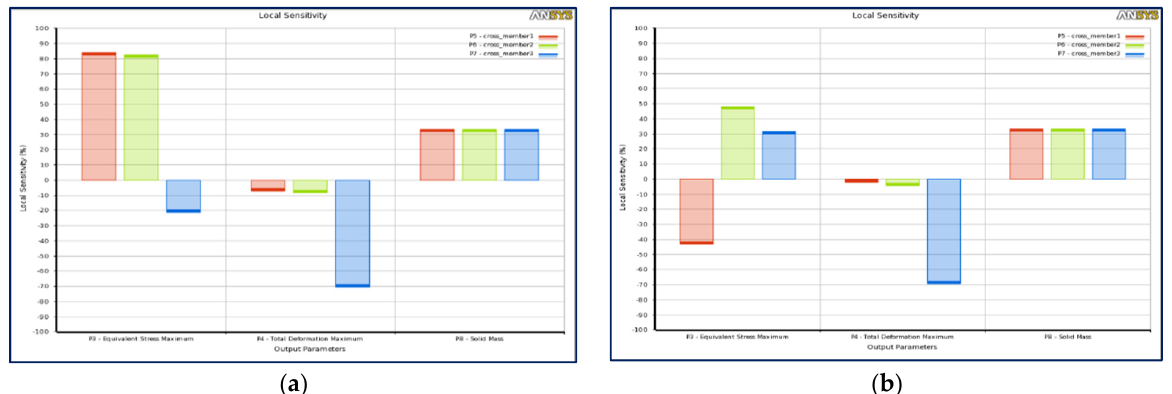
Figure 25 . Sensitivity plot ( a ) for CCD scheme, and ( b ) for optimal space filling design.